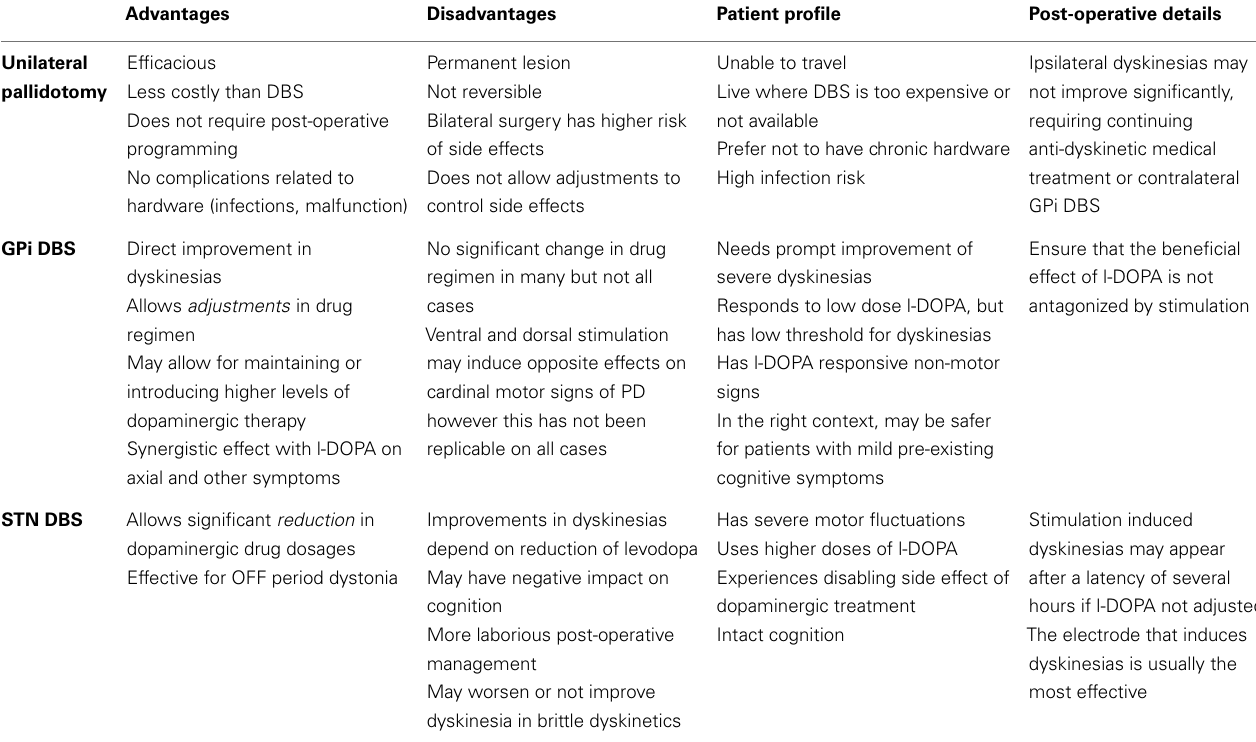
Table 1 | Patient selection and point to be considered when indicating stereotactic surgery for dyskinesias in Parkinson’s disease .